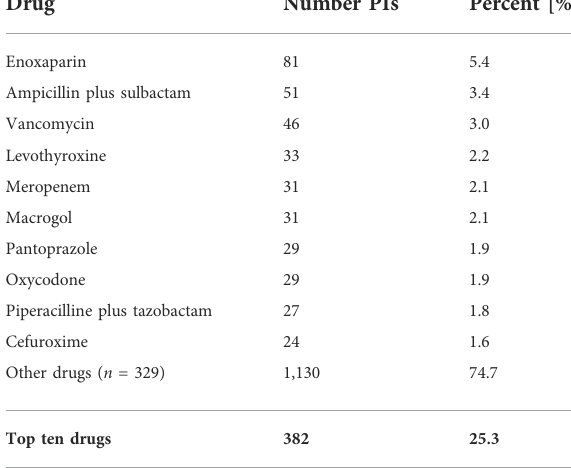
TABLE 4 Top ten drugs for